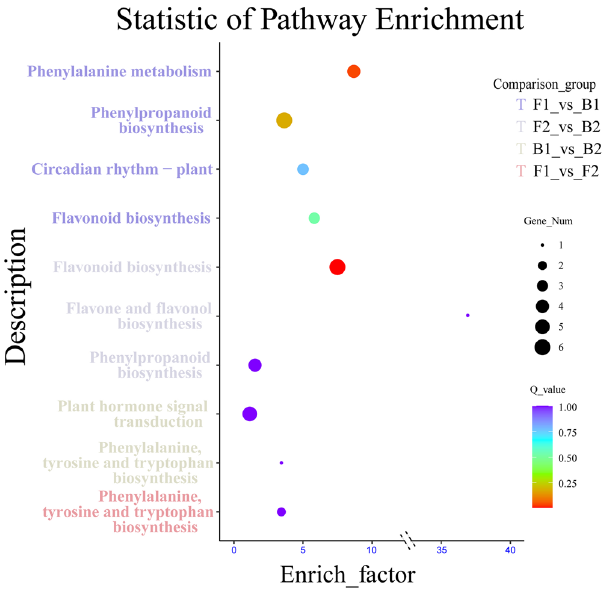
Figure 6. Pathway enrichment analysis of DEGs. The ordinate represents the pathway entry, and the abscissa represents the rich factor. The dots represent the number of significant DEGs, and the significance increases as the dots increase in size. The dots with different colors indicate different Q-values. (The figures were created by R version 4.0.3 based on the KEGG pathway database www. kegg. jp/ kegg/ kegg1.